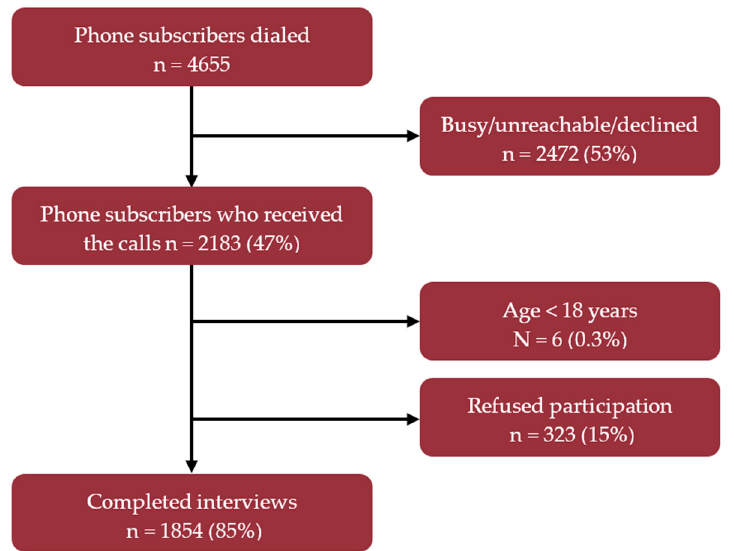
Figure 1. CONSORT diagram showing participants’ enrollment, response rate, and cooperation rate of mobile phone survey during January–March 2021 in Bangladesh.